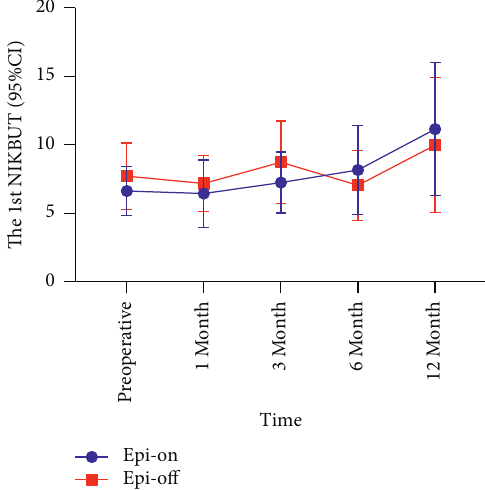
Figure 5: Comparison of the 1st NIKBUT during the 12-month follow-up period. NIKBUT: Noninvasive Keratograph breakup time; CI: confidence